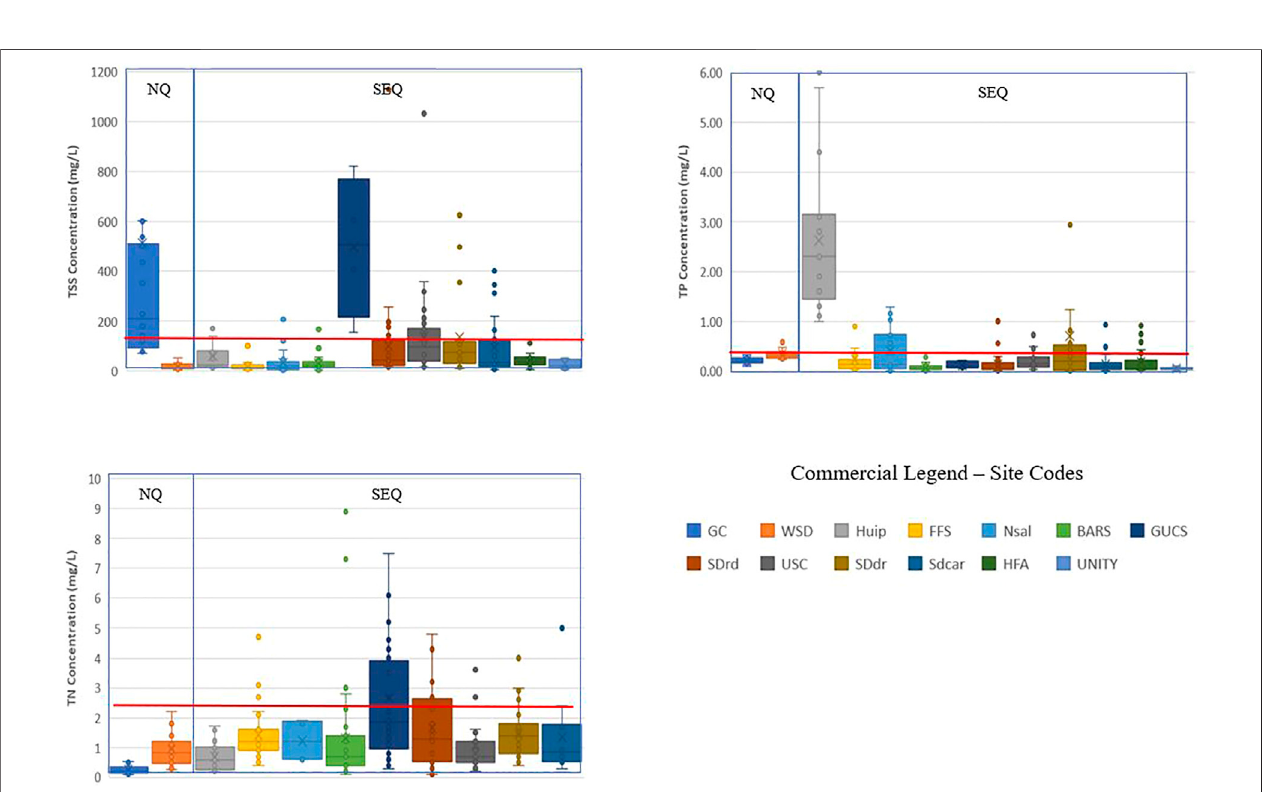
FIGURE 4 | Summary commercial landuse TSS, TP and TN concentrations for each site by geographic region, with typical values shown in red (WbD, 2018).